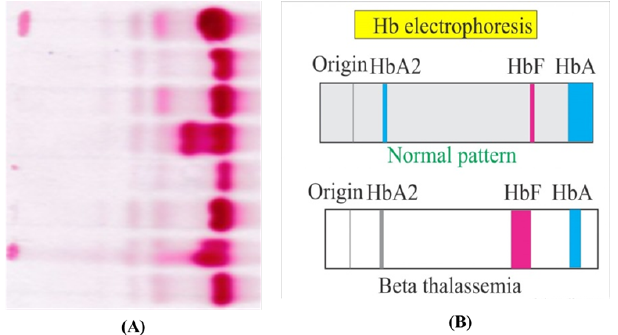
Figure 1. ( A ) Raw Hb electrophoresis images from eight subjects, and ( B ) standard normal and beta thalassaemia patterns in Hb electrophoresis